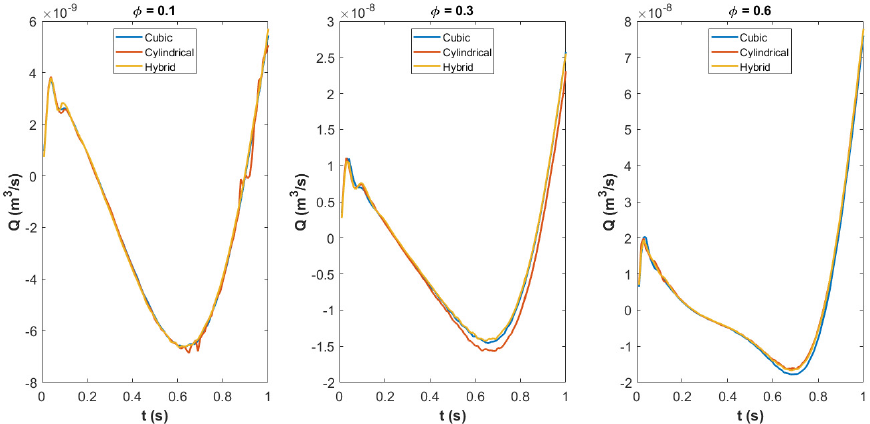
Figure 12. Volumetric flow rate history during the ramp time for different initial particle arrangements. Table 2. Effect of particle arrangement in the SPH simulations.